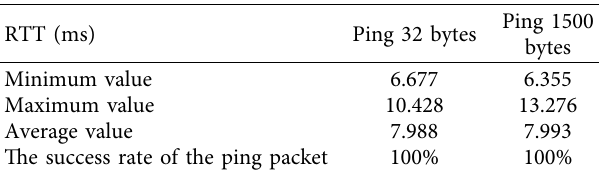
Table 5: Statistics of user plane